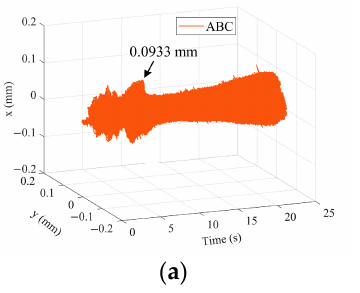
Figure 14. Rotor displacement from standstill to 12,000 rpm (200 Hz) accelerated rotation experiments: ( a ) ABC; ( b ) GESO-BC; ( c ) MESO-BC.